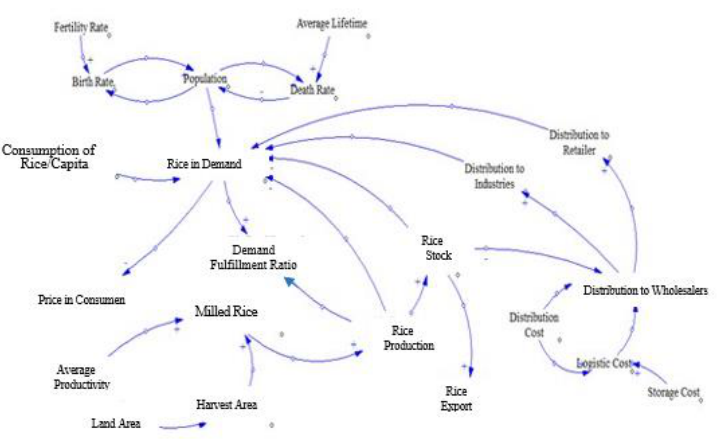
Figure 1: Causal Loop Diagram (Caustic